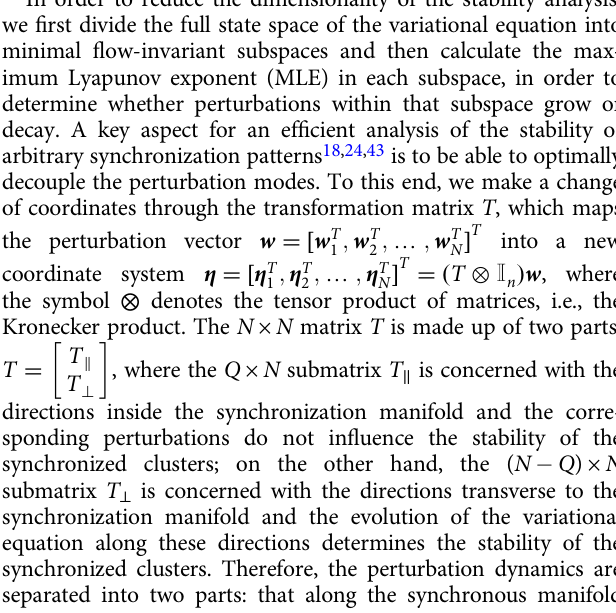
We collect all state trajectories in the vector x ð t Þ ¼